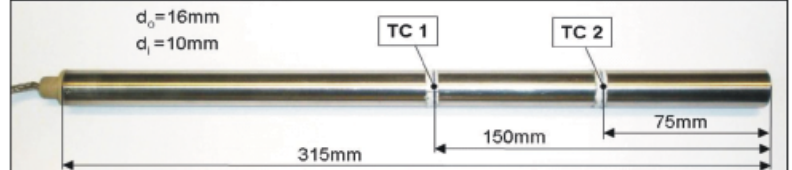
Fig. 3. The thermal conductivity probe prototype LNP01. This hollow cylindrical sensor is heated over its whole length.